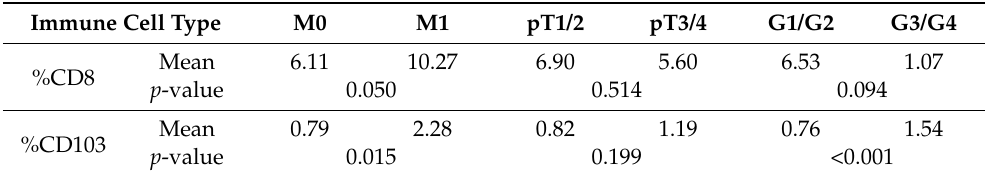
Table 7. Comparison of intratumoral immune cells in relation to clinico-pathological data (Mann– Whitney U test, Berlin cohort, n = 197 patients).